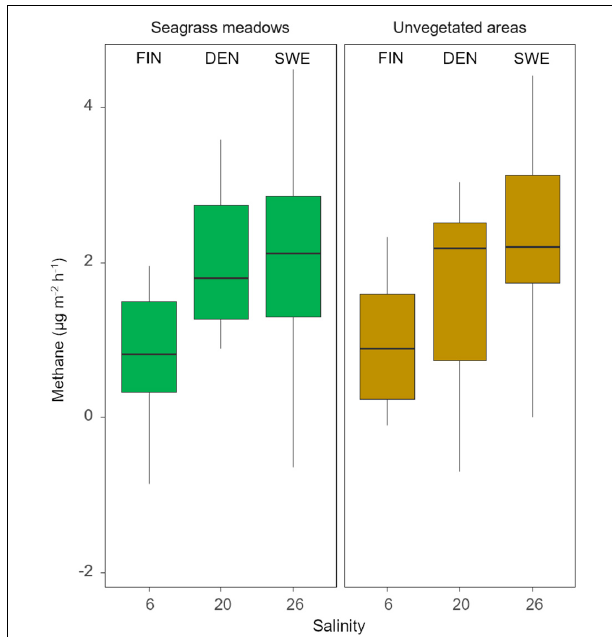
FIGURE 4 | Box-and-whisker plot summarizing methane emissions from the sediment to the gas-filled pocket in the incubation chambers in seagrass meadows and adjacent unvegetated areas in relation to average salinities in the different regions. The solid lines within the boxes indicate median values, the boxes represent the 25th to the 75th percentiles and the vertical whisker bars show the 5th to the 95th percentiles of the